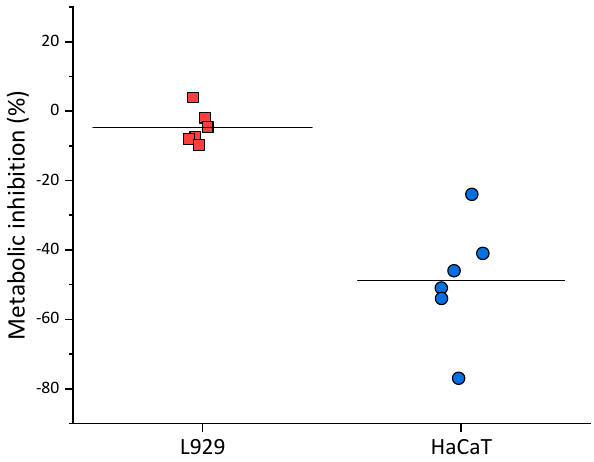
Figure 5. Metabolic inhibition of optimal hydrolysate with a concentration of 1 mg/mL for 24 h against two mammalian cell lines, namely: human keratinocyte HaCaT cells; and mouse fibroblast L929 cells. Each boxplot represents n = 6.